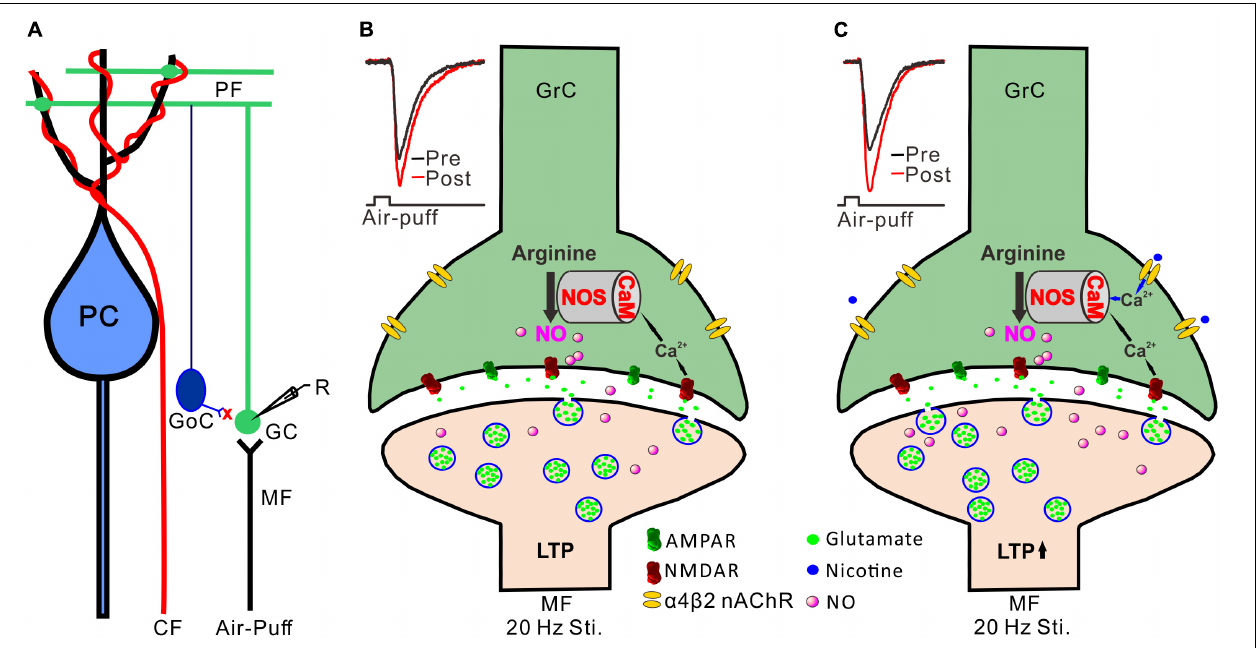
FIGURE 6 | Possible mechanism of nicotine-induced facilitation of MF-GrC LTP. (A) Composition of cerebellar cortical microcirculation and the recording diagram of MF-GrC synaptic transmission evoked by facial stimulation. The inhibitory inputs of GoC were blocked by picrotoxin. (B) 20 Hz facial stimulation induced MF-GrC LTP via the NMDA receptor/NO cascade signaling pathway. Insert, representative traces showing the evoked MF-GrC synaptic transmission before (pre) and after (post) delivery of 20 Hz stimulation. (C) Activation of α 4 β 2 nAChR enhanced Ca 2 + influx and facilitated NO generation in GrC resulting in an enhancement of MF-GrC LTP expression. Insert, representative traces showing the evoked MF-GrC synaptic transmission before (pre) and after (post) delivery of 20 Hz stimulation. PC, Purkinje cell; CF, climbing fiber; MF-mossy fiber; GoC, Golgi cell; GrC, granule cell; R, recording electrode; NOS, nitric oxide synthase; NO, nitric oxide; LTP, long-term